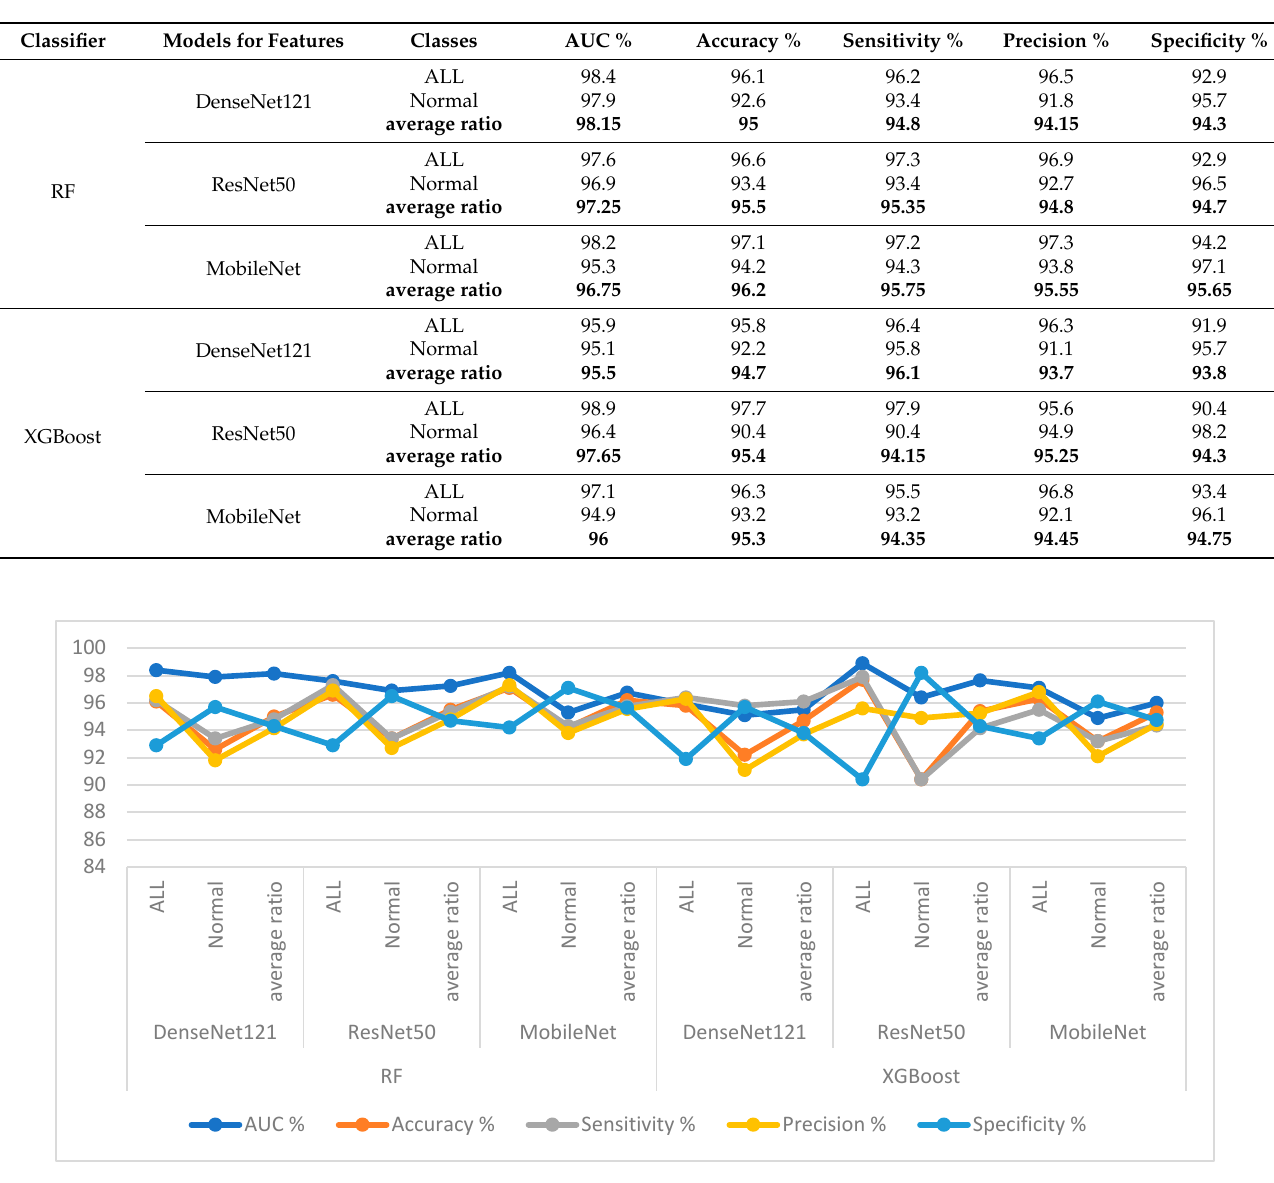
Table 6. Results of the RF and XGBoost classifiers based on the features of the CNN models of the C-NMC 2019 dataset for the diagnosis of acute leukemia.